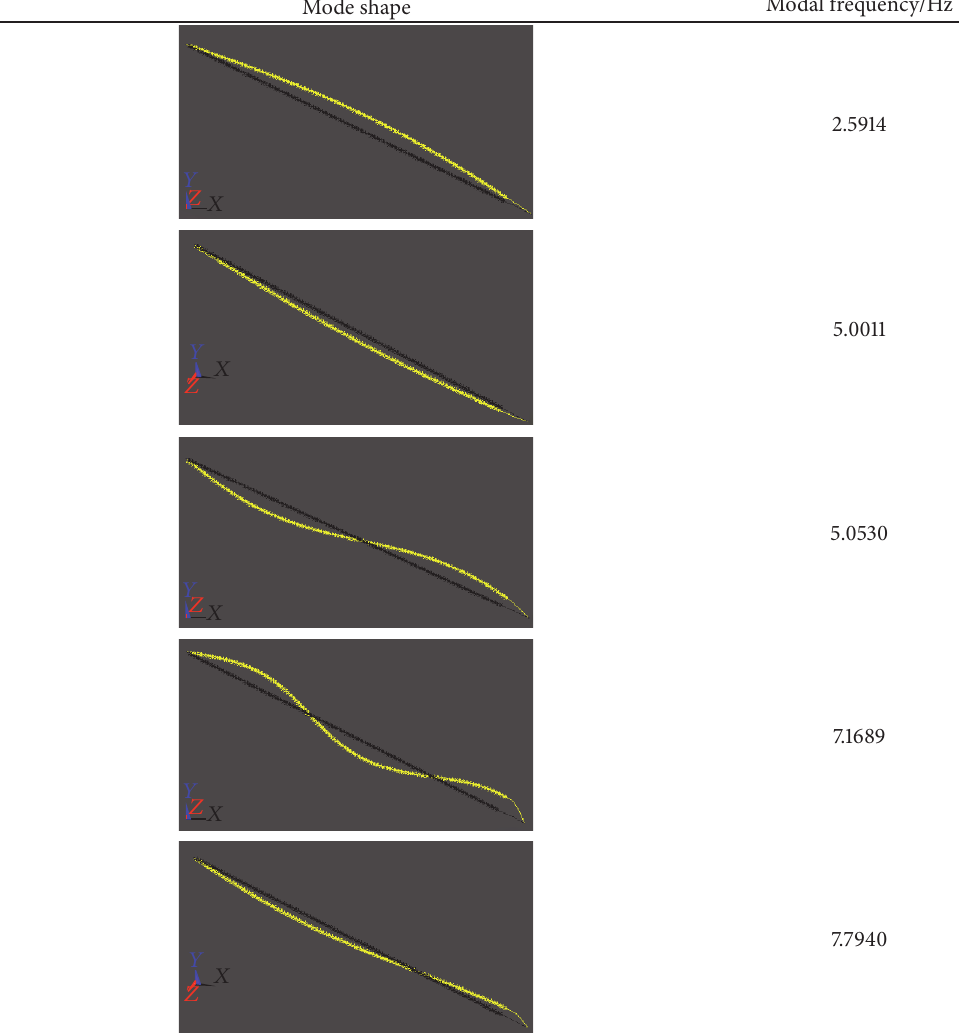
Table 2: Vibration mode and frequency of the cable model analyzed by the software ANSYS.